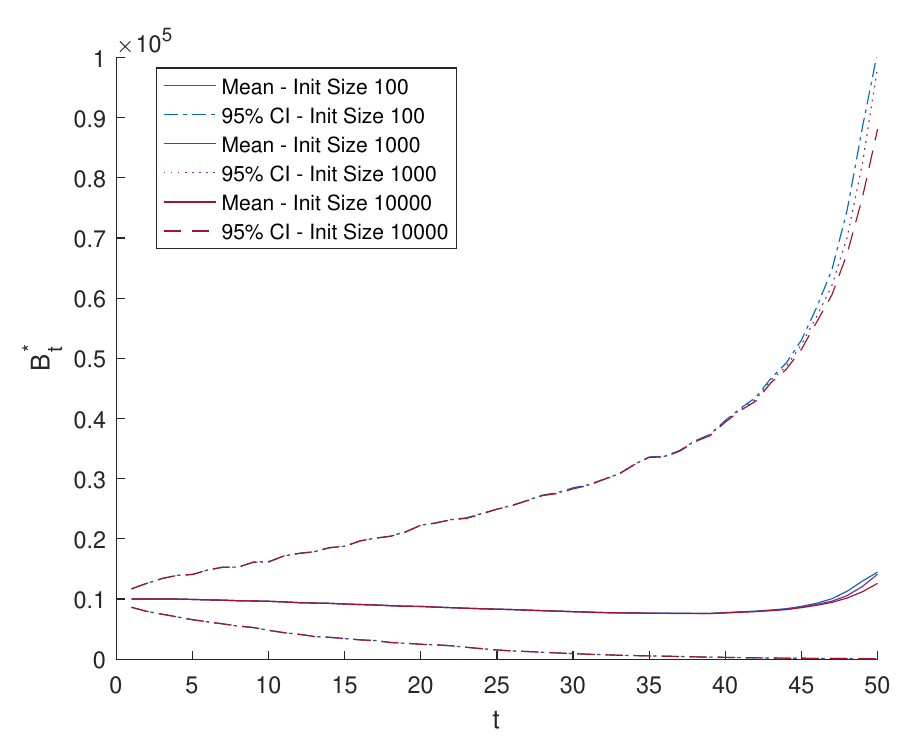
Figure 10. Initial Pool Size Comparison: 100 vs. 1k vs.